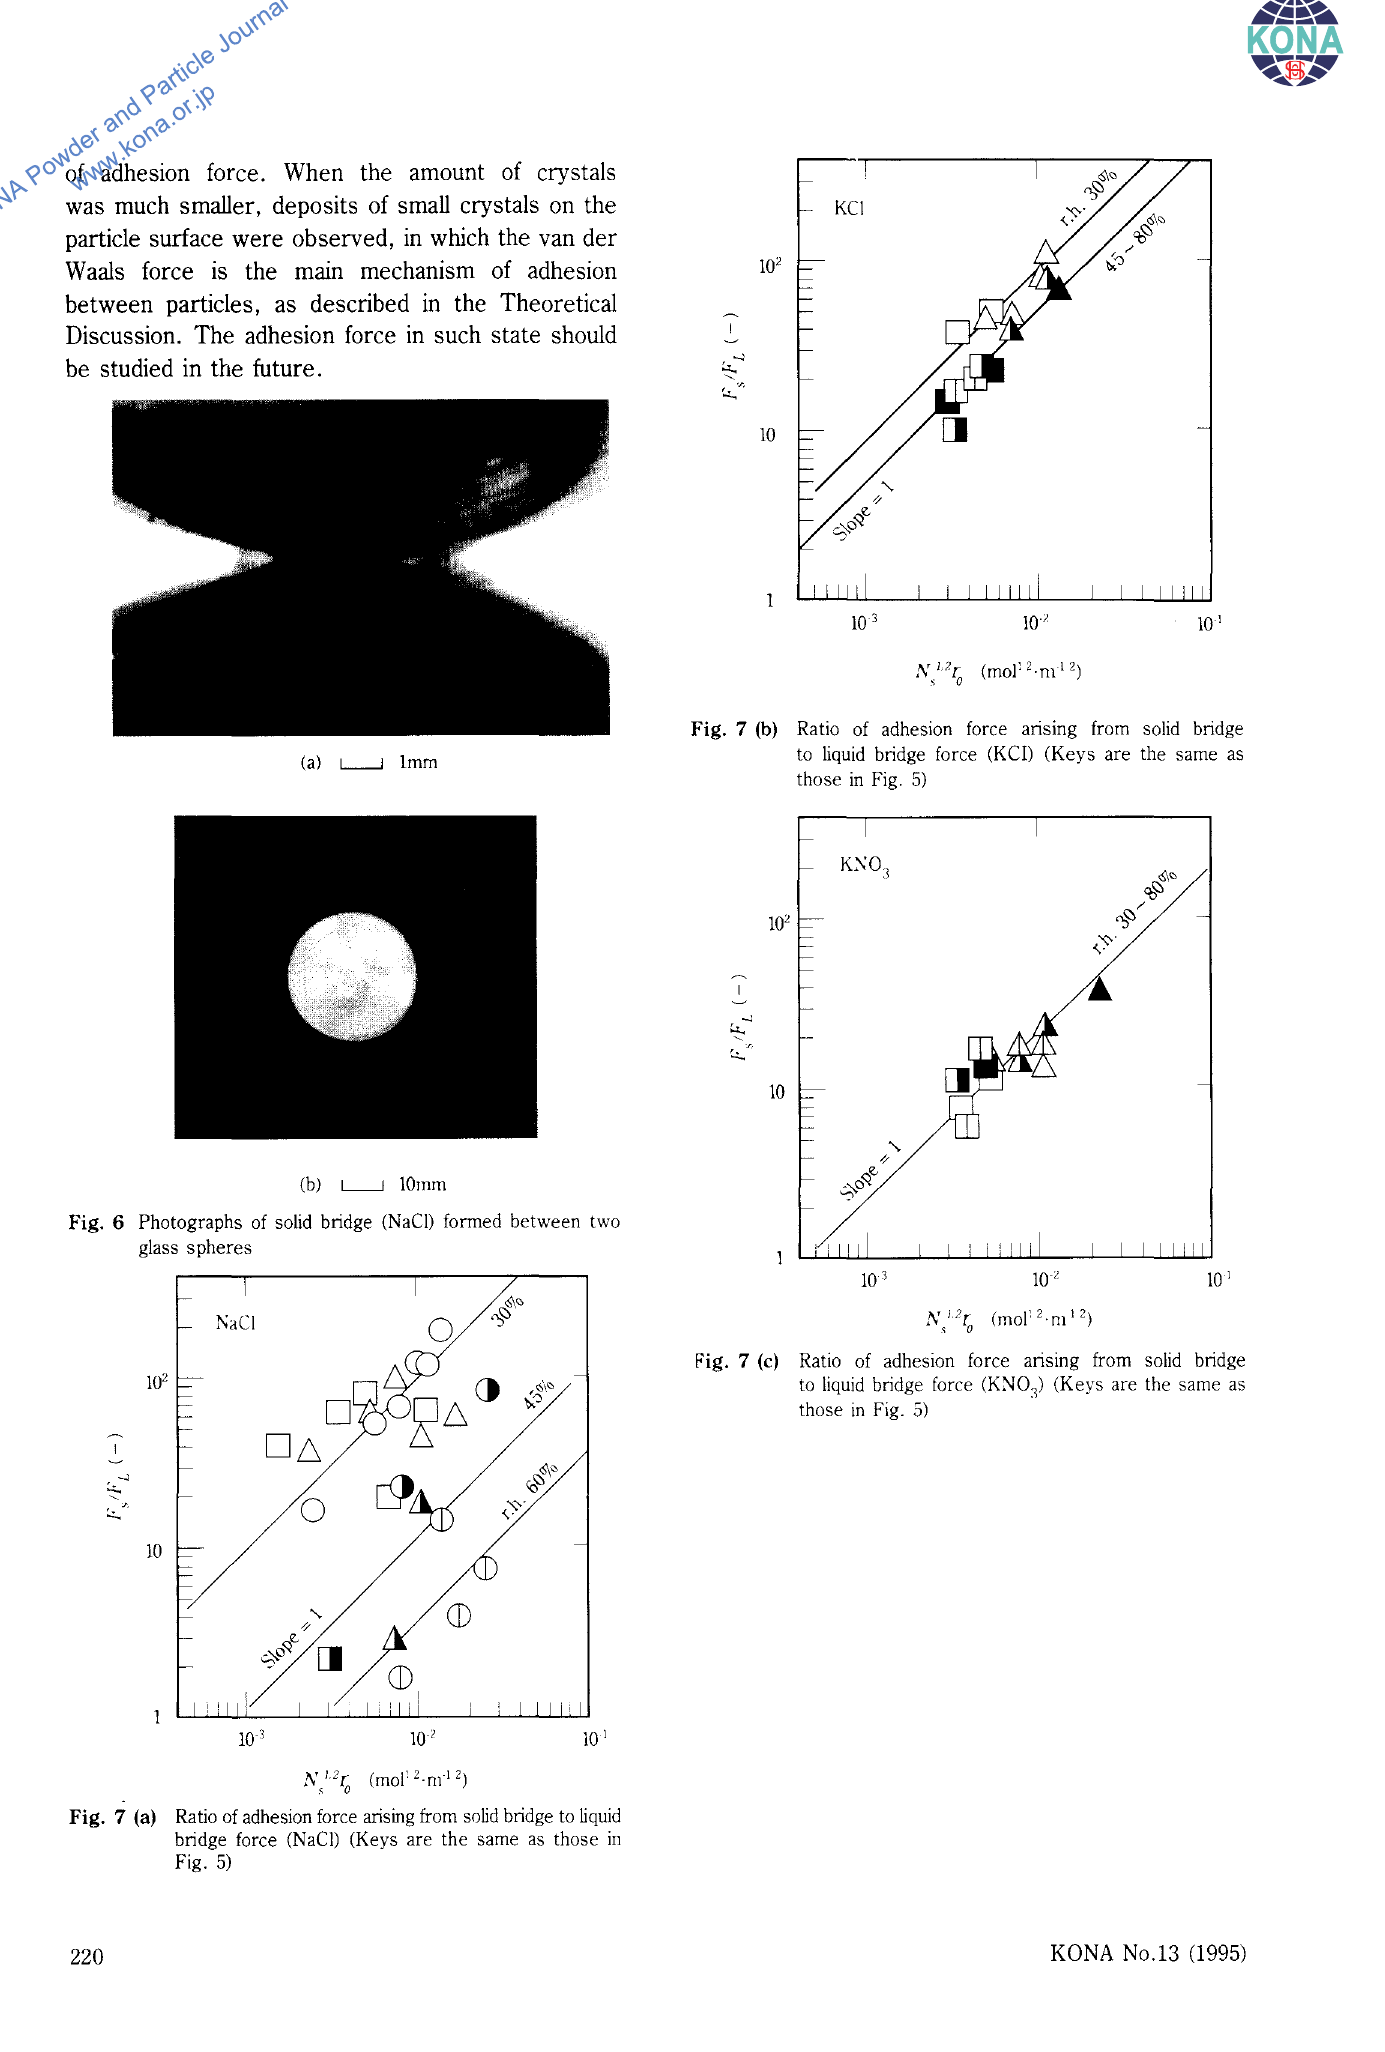
Fig. 7 (a) Ratio of adhesion force arising from solid bridge to liquid bridge force (N aCl) (Keys are the same as those in Fig. 5)